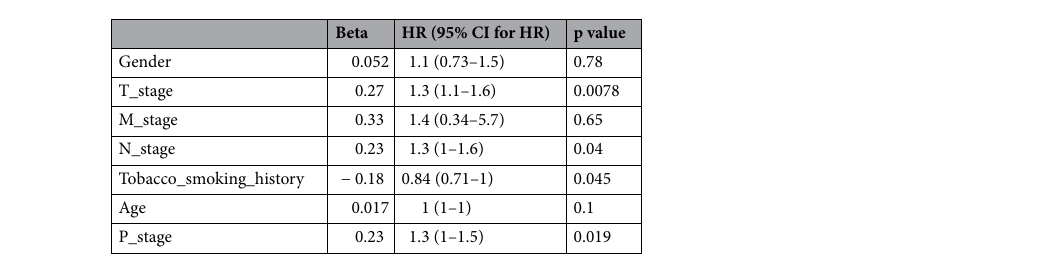
Table 8. Univariate CoxPH results for clinical parameters.